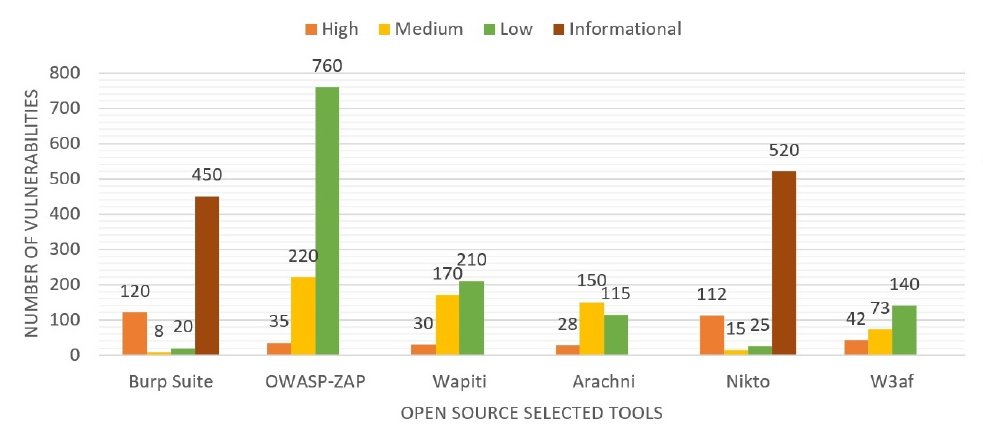
Figure 2. Detected vulnerabilities in open-source